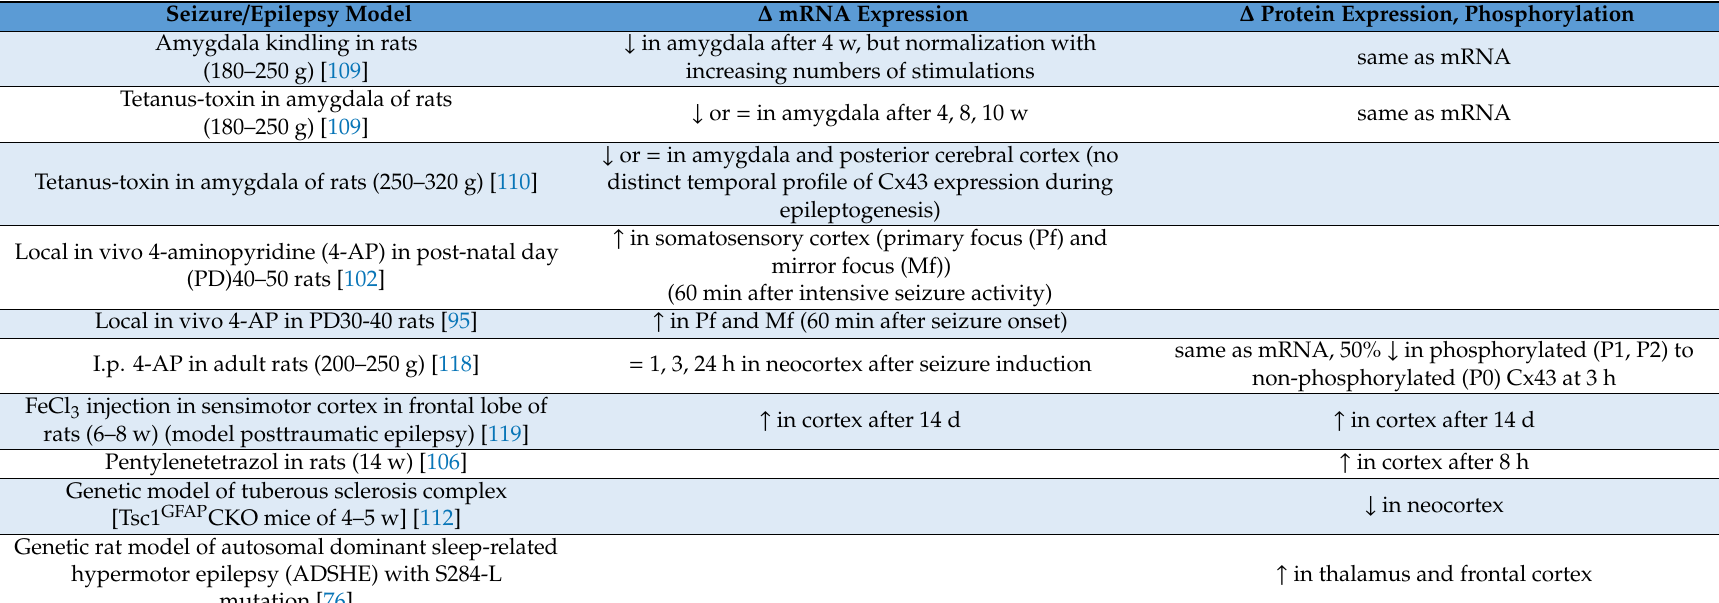
Table 3. Cx43 expression and phosphorylation changes in other seizure-relevant regions in rodent models of seizures and